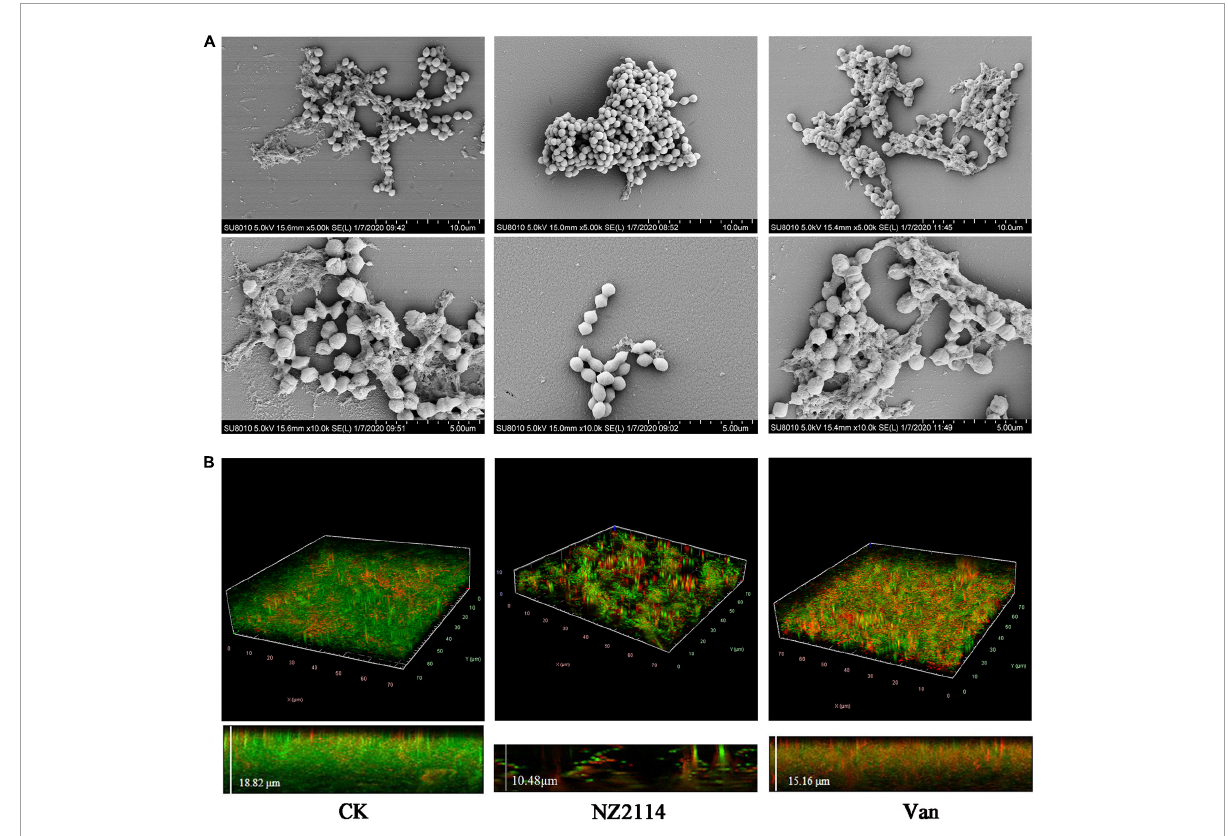
FIGURE3 Effects of NZ2114 on S. dysgalactiae biofilms by SEM and CLSM observation. (A) Biofilms observation by SEM. (B) Biofilms observation by CLSM. Live cells are stained in green by SYTO9 and dead cells are stained in red by PI. CK: the untreated S. dysgalactiae biofilms. Van: vancomycin.